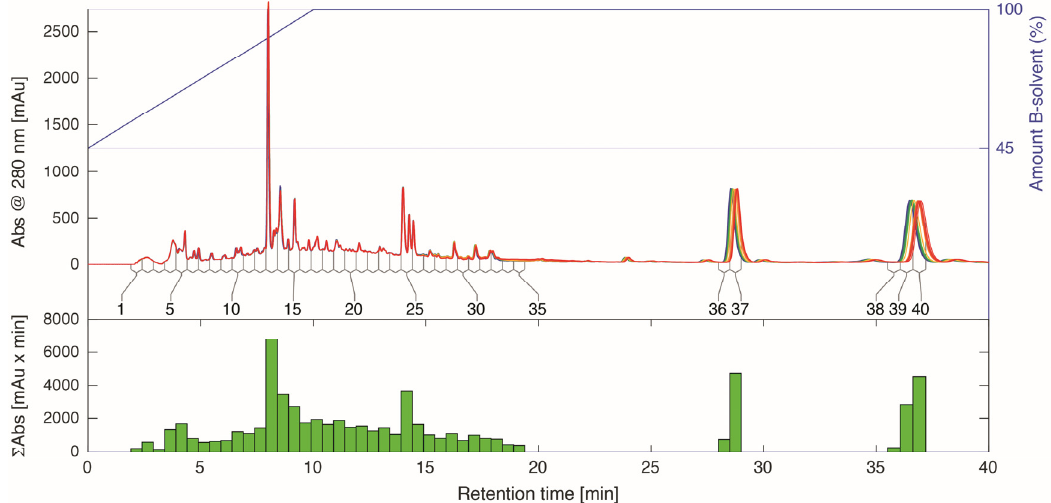
Figure 4. HPLC-chromatograms from a time-sliced fractionation of 20 repetitive analytical-scale separations (each corresponding to 0.5 mg dry weight on-column) of Radix Astragali sample #3 extract ( top ); Chromatographic profiles at 280 nm are overlaid with the first separation in blue color and the last in red color (intermediate separations in green and yellow). The fraction numbers of the 40 fractions are indicated under the chromatographic profiles and the gradient elution program on the right ordinate. The sums of UV-intensities are shown as bars plotted along the retention time axis ( bottom ).